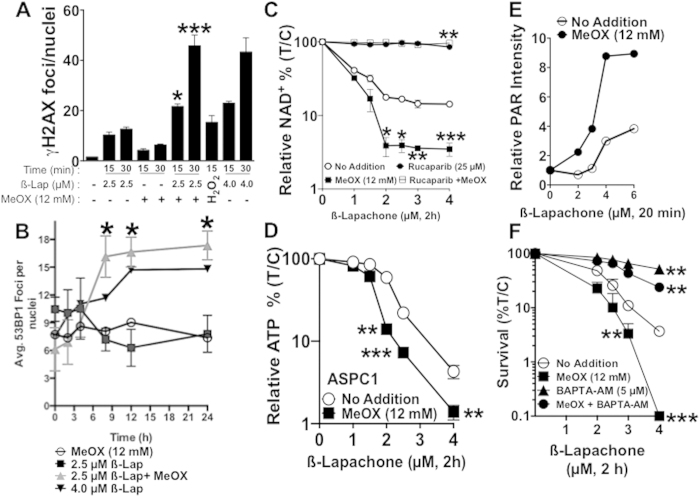
MeOX sensitizes cells to ß-lap by potentiating DNA damage and PARP1 hyperactivation.(A) MeOX enhances DSB formation in MiaPaca2 cancer cells. Average γH2AX foci/nuclei were assessed in ß-lap-treated (μM, 2 h) MiaPaca2 cells, + MeOX (12 mM) at 15 and 30 min during exposure. H2O2 (0.5 mM, 15 min) was used as a positive control. (B) Average 53BP1 foci/nuclei in ß-lap-treated (μM, 2 h) MiaPaca2 cells, ±12 mM MeOX over time (h). Graph represents average foci of three separate experiments. (C) Relative NAD+ levels in MiaPaca2 cells 2 h after treatment with ß-lap, ±12 mM MeOX, with or without Rucaparib (25 μM) in sextuplicate, means ± SEM. (D) Relative ATP levels in ASPC1 cells 2 h after treatment with ß-lap, ±12 mM MeOX. (E) Western blot quantification of relative PAR-PARP1 formation (using α-tubulin for loading) in MiaPaca2 cells 20 min after exposure to various doses of ß-lap ±12 mM MeOX. (F) Clonogenic survival of MiaPaca2 cells pre-treated with 5 μM BAPTA-AM (Ca2+ chelator) for 30 min followed by treatment with ß-lap (μM, 2 h), ±12 mM MeOX. Data represent survival means ±SEM from quadruplicate samples.